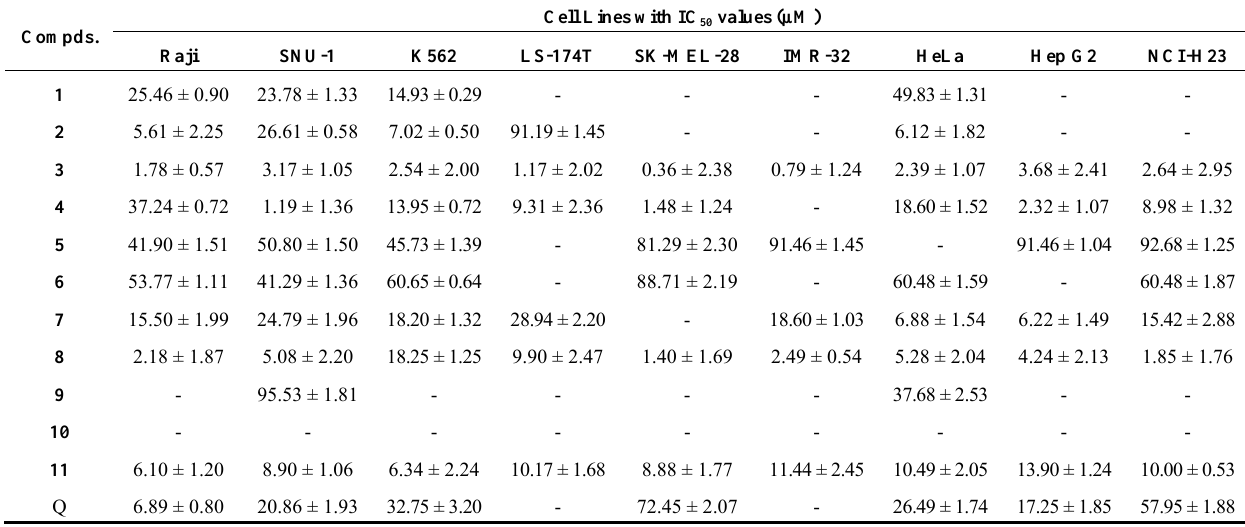
Table 2. IC values of a Panel of Human Cancer Cell Lines Treated with Pure Compounds 50 from the three Mesua species.